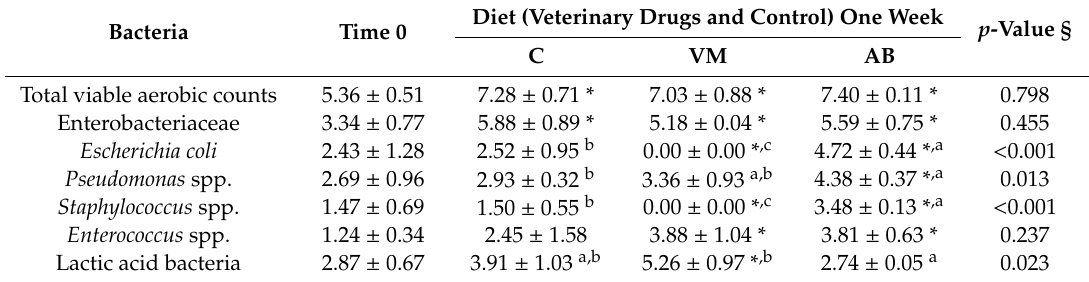
Table 1. Bacterial counts (log Colony-Forming Unit (CFU) per samples ± s.d.) obtained from honey bees’ ventriculum after one week of veterinary drugs administration. Bacteria Time 0